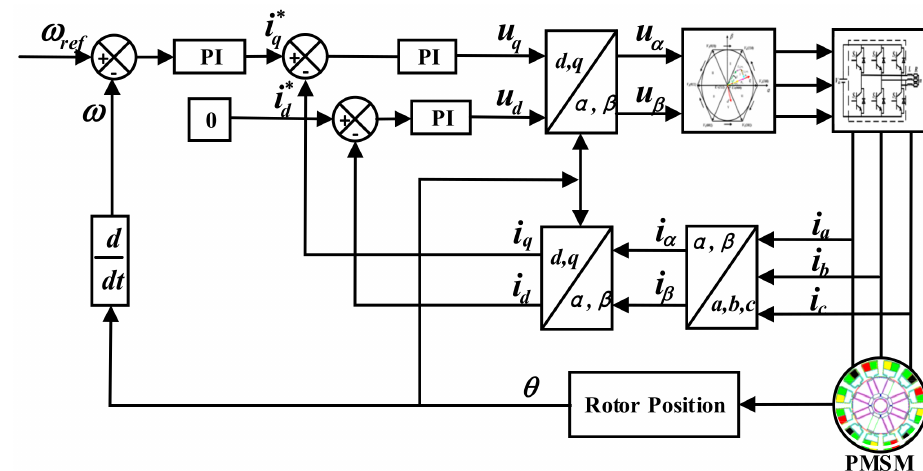
Figure 1. Implementation of the control system.